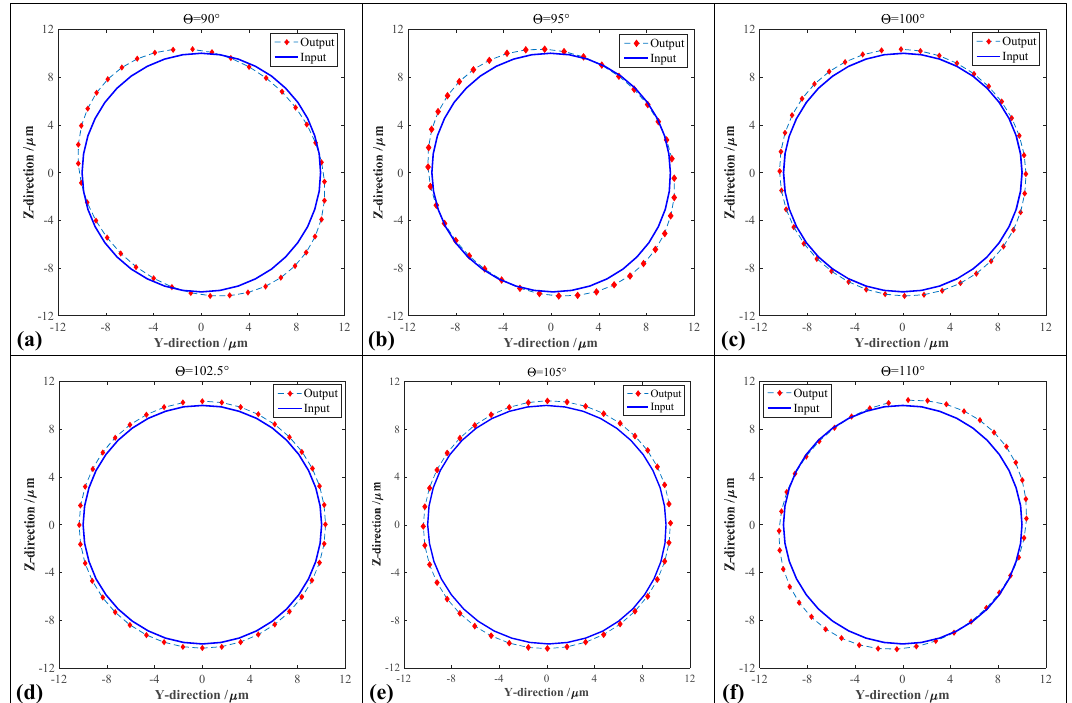
Figure 2. Schematic diagram of the finite beam-based matrix modeling (FBMM) method for two typical flexure beams. ( a ) Right circular flexure beam (RCFB); ( b ) Leaf-spring flexure beam (LSFB).